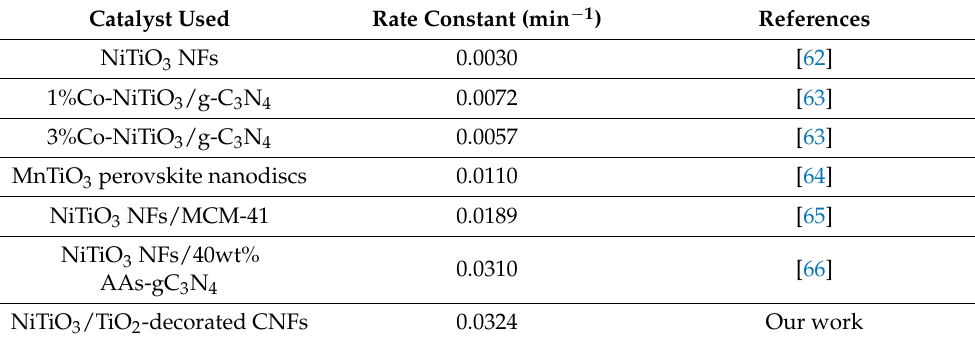
Table 3. Performance comparison of our catalyst with those reported in the literature. Catalyst